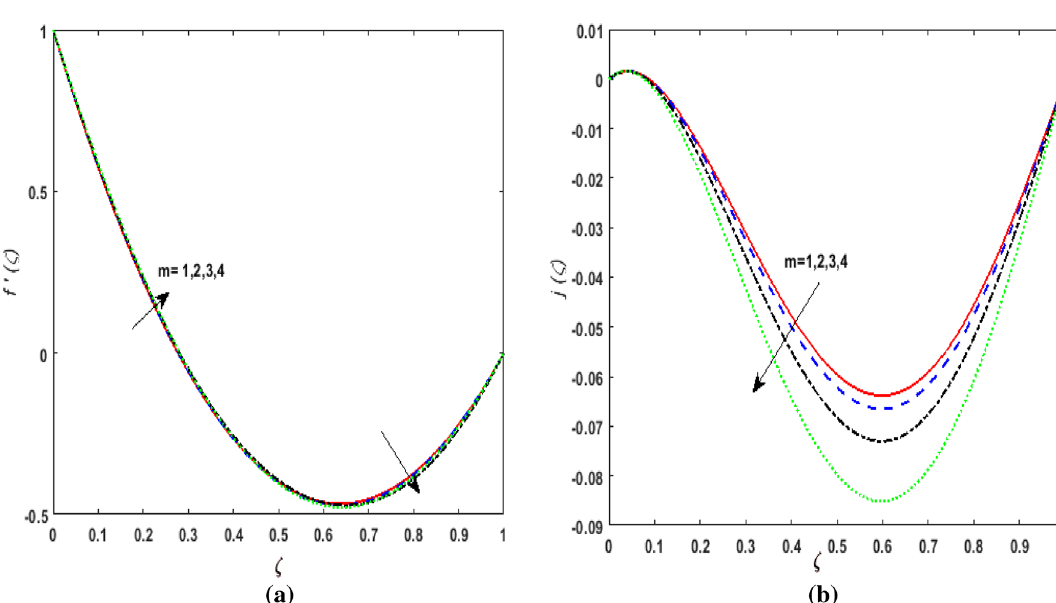
Figure 6. ( a ) Effect of hall parameter m on velocity f ′ (ζ) . ( b ) Effect of hall parameter m on velocity j (ζ)